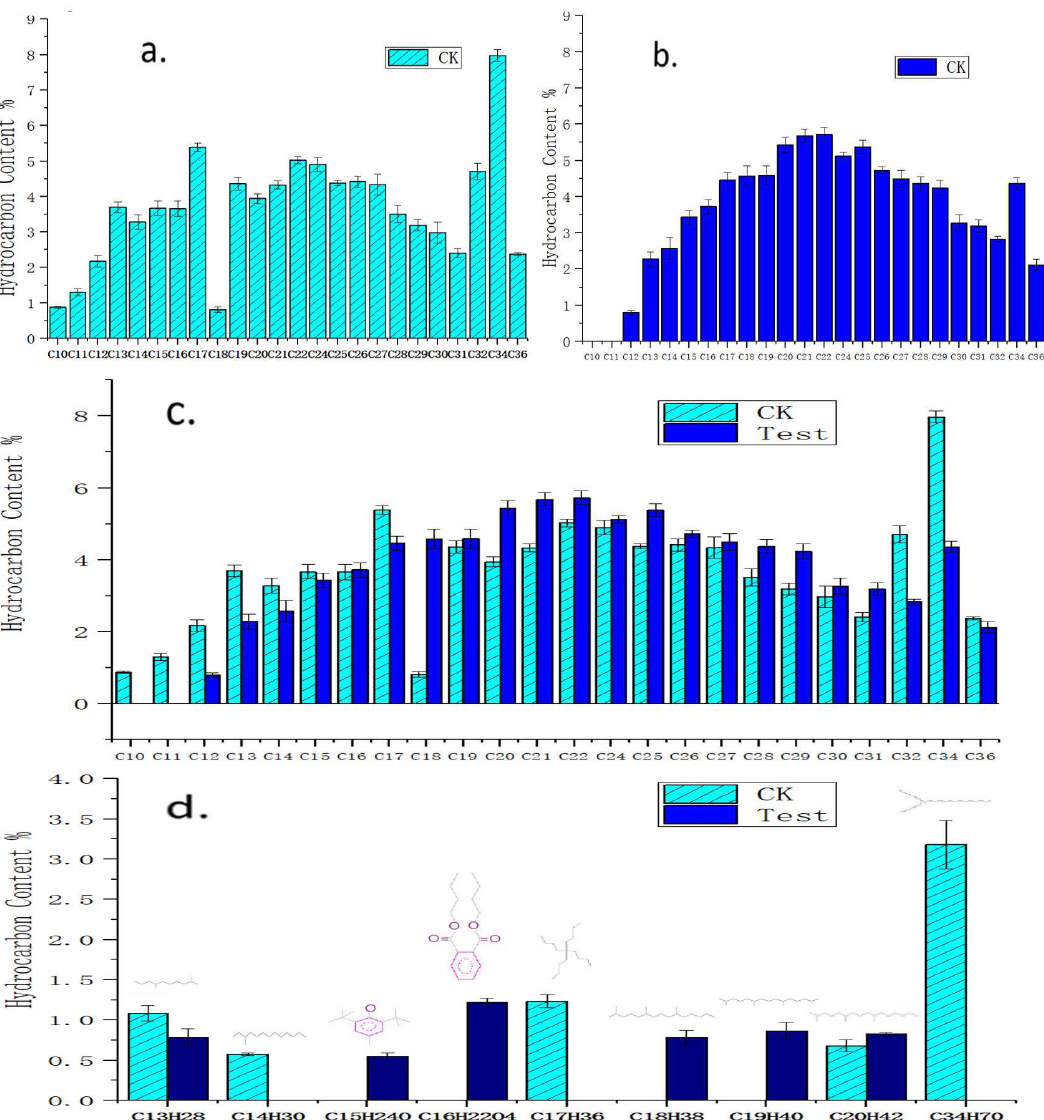
Figure 4. Compound contents in residual crude oil after biodegradation by the H9-3 strain. CK: Crude oil incubated for 21 days with no additive; Test: Crude oil incubated for 21 days with additives A. pittii H9-3). ( a ) The content of hydrocarbons in crude oil before biodegradation (day 0); ( b ) the content of hydrocarbons in crude oil after 21 days of biodegradation by strain H9-3; ( c ) n -alkane in crude oil after biodergadation; ( d ) i -alkane and oxygenated compounds in crude oil after